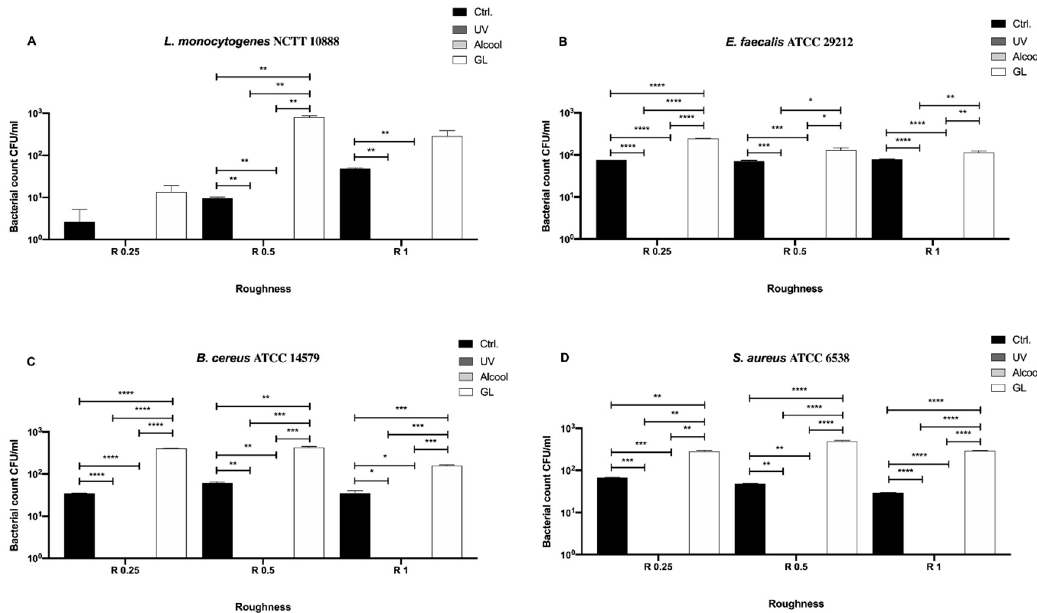
Figure9. AntibacterialactivityofUV,alcoholandGLagainstGram-positivebacteria( A ) L.monocytogenes NCTT 10888, ( B ) E. faecalis ATCC 29212, ( C ) B. cereus ATCC 14579 and ( D ) S. aureus ATCC 6538